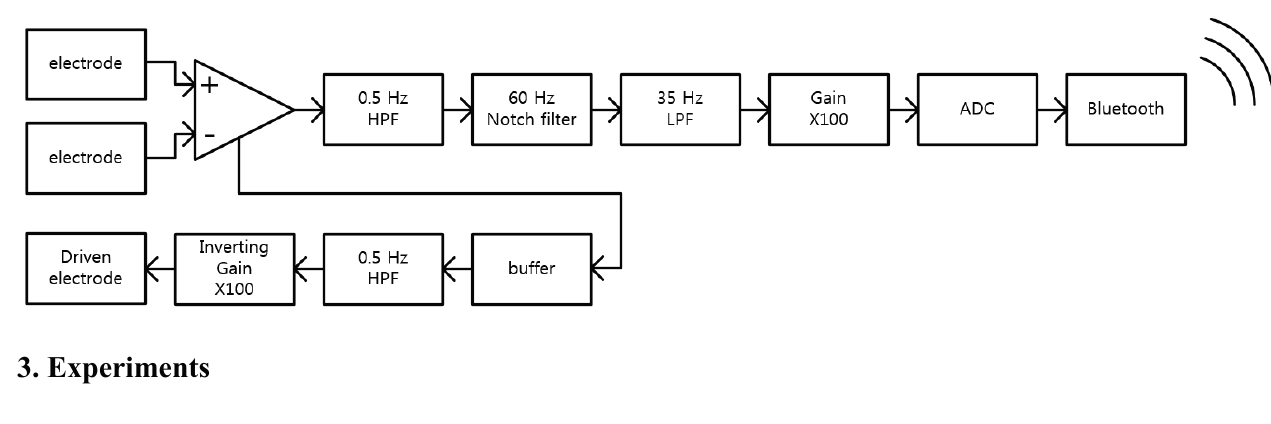
Figure 5. Schematic of the overall